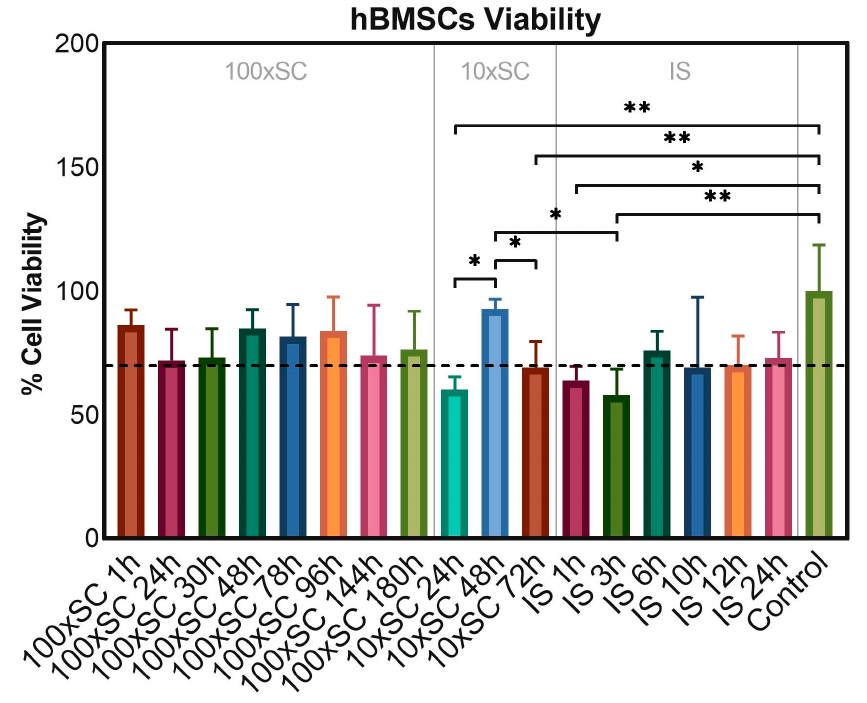
Figure 9. In vitro cell viability of the final and the transient powders after three days of incubation in direct contact with hBMSCs. ‘Control’ series represented cells cultivated on polystyrene without CaP samples. Error bars represent the mean ± standard deviation of three replicates. Multiple comparisons were performed on relative fluorescent units via one ‐ way ANOVA with Tukey’s correction; significant differences between groups of samples were indicated with asterisks (* for p ≤ 0.05, ** for p ≤ 0.01).